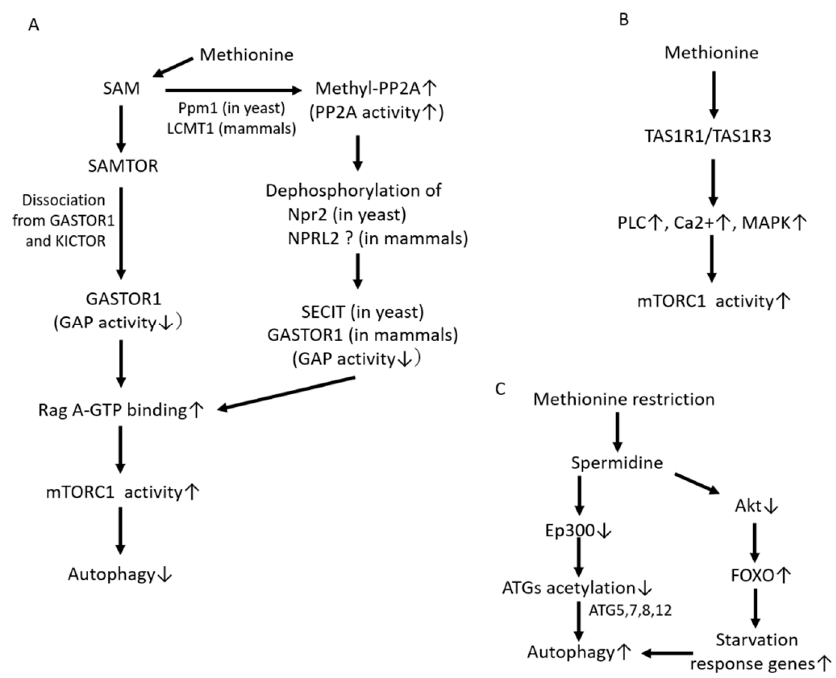
Figure 2. Mechanism of the activation of mTORC1 and the regulation of autophagy by methionine metabolism. ( A ) Regulation of mTORC1 and autophagy by methionine: Intracellular SAM concentration is sensed by SAMTOR, leading to mTORC1 activation and autophagy suppression through the inactivation of GASTOR1, a negative regulator of mTORC1. On the other hand, intracellular SAM promotes the methylation of protein phosphatase 2A (PP2A) via Ppm1 (in yeast) or leucine carboxy methyltransferase 1 (LCMT1) (in mammals), resulting in its activation. Methylated PP2A activates mTORC1 and suppresses autophagy, through the inactivation of SECIT in yeast and GASTOR in mammals via the dephosphorylation of Npr2 in yeast and possibly NPRL2 in mammals. ( B ) TAS1R1–TAS1R3 can serve as a sensor for extracellular methionine, leading to mTORC1 activation through phospholipase C (PLC) activation, an increase in intracellular calcium, and mitogen-activated protein kinase (MAPK) activation. ( C ) Spermidine induced by methionine restriction can promote autophagy by decreasing the acetylation of autophagy-related genes (ATGs) by suppressing Ep300. In addition, spermidine can promote autophagy through the upregulation of starvation response gene expression induced by the suppression of Akt and the transcriptional activation of FOXO. ↑ : upregulation, ↓ : downregulation.